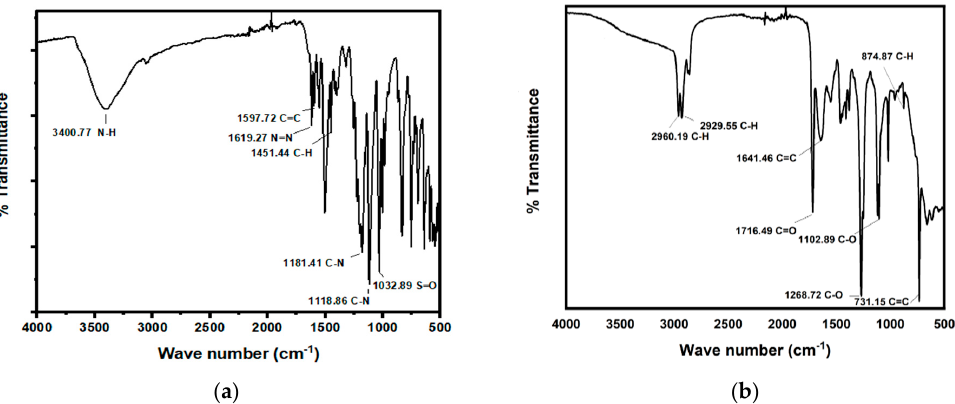
Figure 6. ( a ) FTIR spectra before degradation of orange II and ( b ) FTIR spectra after orange II deg- radation by B.